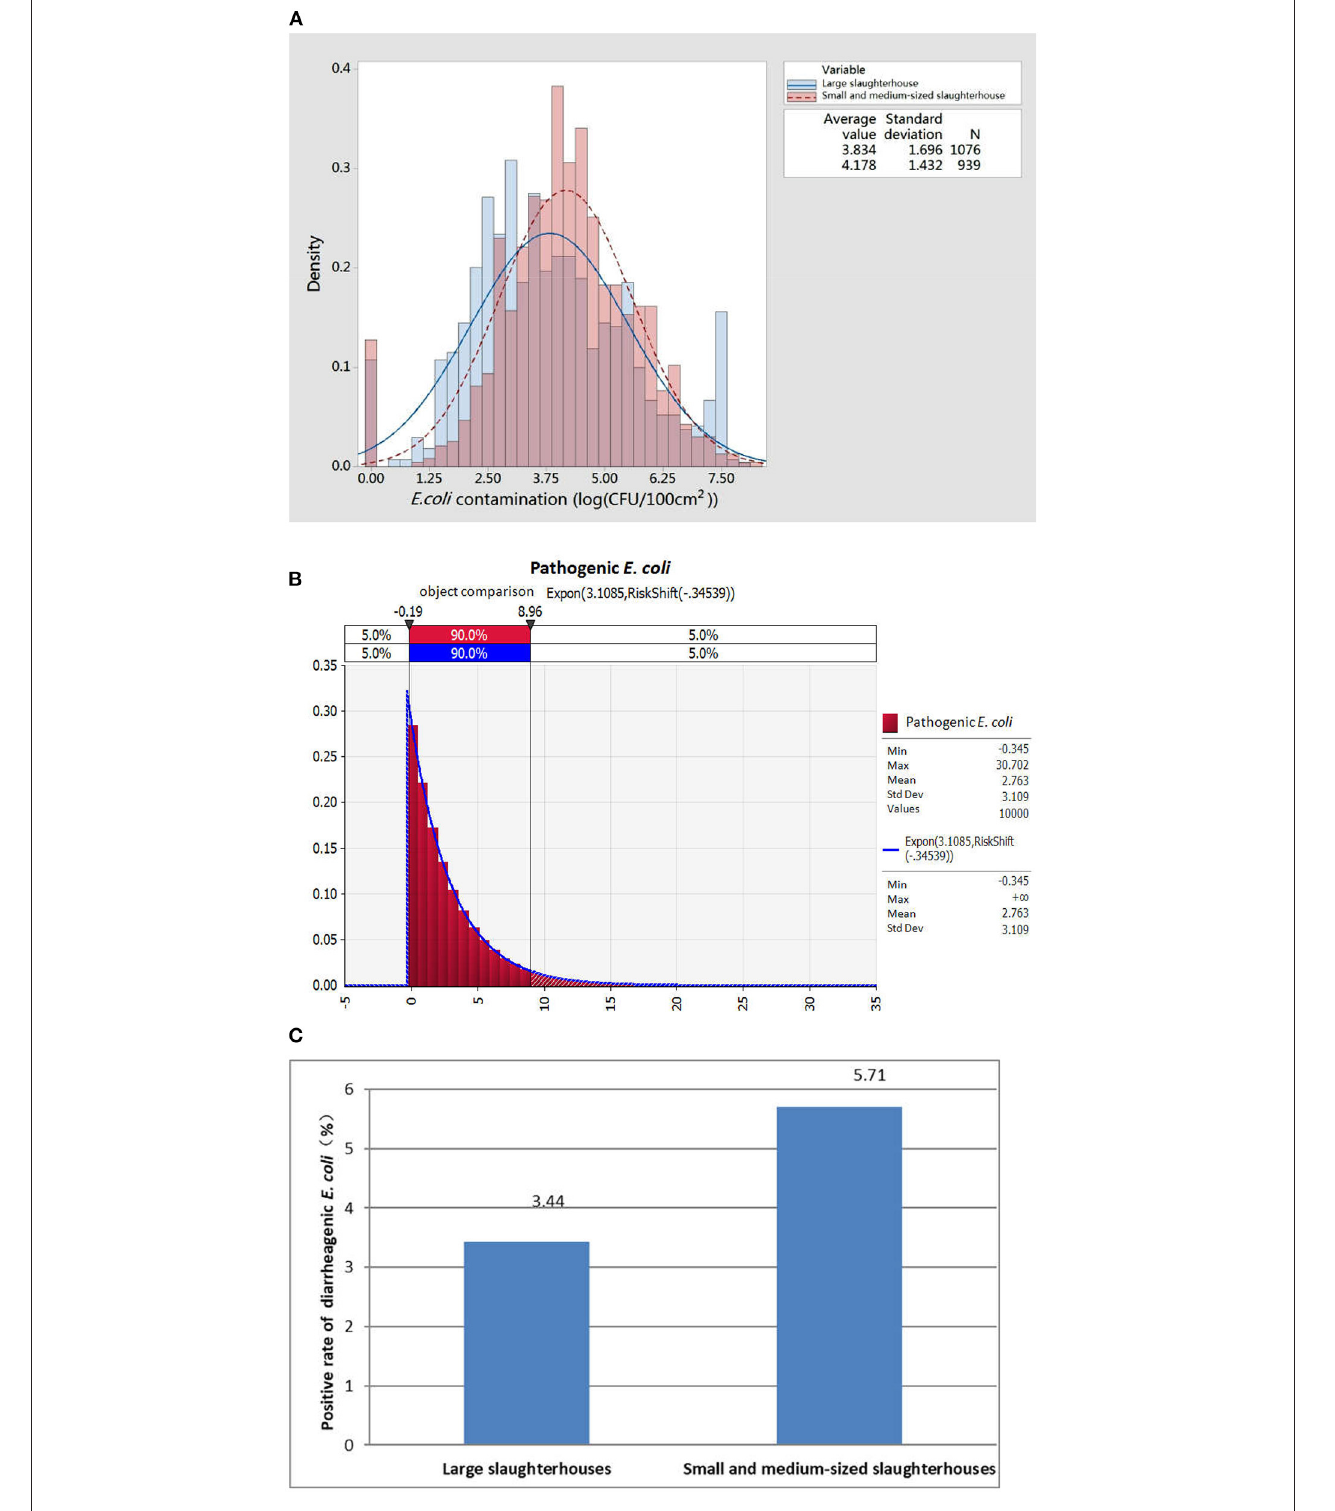
FIGURE 1 | Monitoring of Escherichia coli and diarrheagenic E. coli contamination in pork produced in different types of slaughterhouses. (A) Distribution of E. coli contamination in pork from different types of slaughterhouses. (B) Exposure assessment results of diarrheagenic E. coli in pork during the slaughter process. (C) Exposure of diarrheagenic E. coli in pork produced in different types of